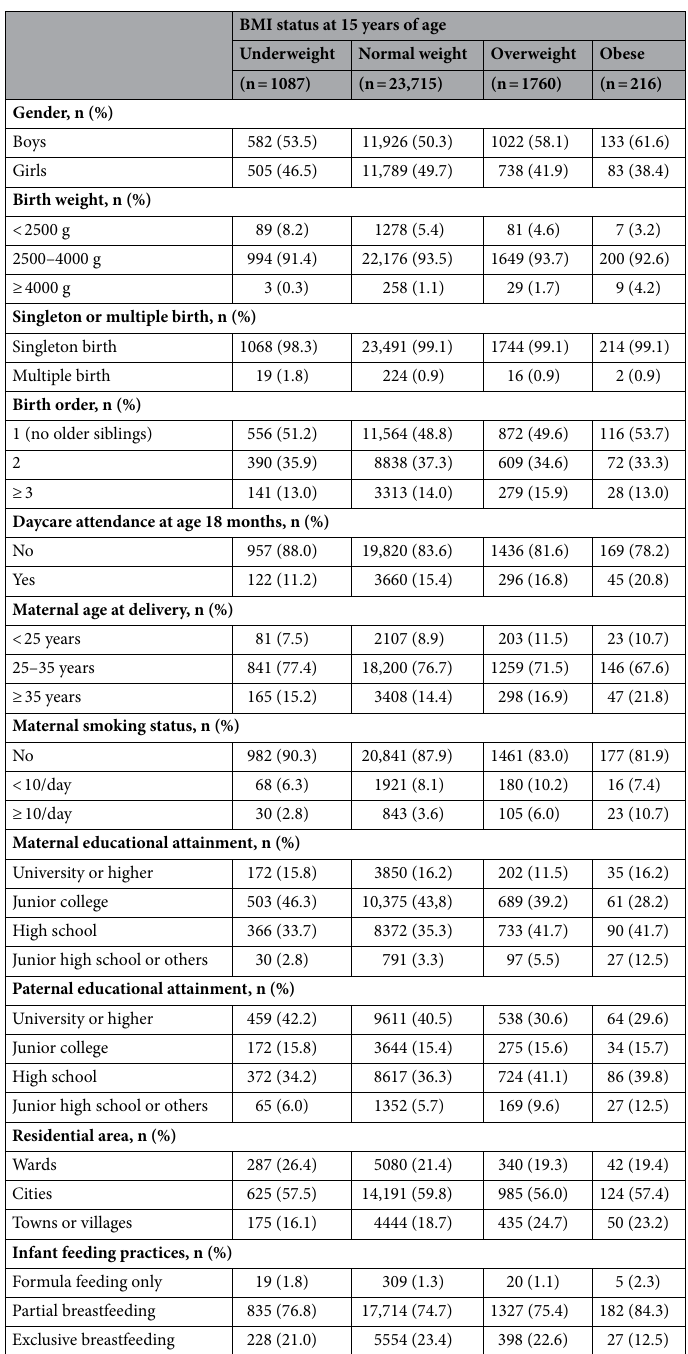
Table 1. Demographic characteristics of children included in the analysis at age 1.5 years by BMI status at age 15 years (N = 26,778). Five participants had missing birth weight information, 273 participants had missing daycare attendance information, 131 participants had missing maternal smoking information, 385 participants had missing maternal educational attainment information, and 569 participants had missing paternal educational attainment